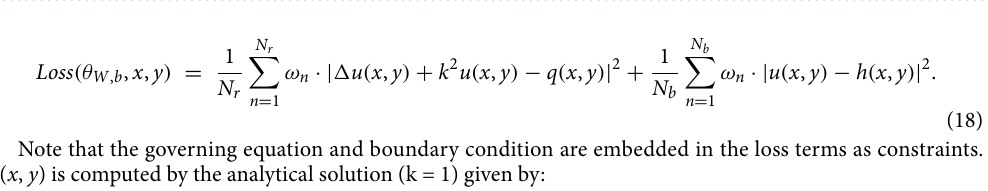
Figure 3. The convergence of DFS-Net (on the log scale) on the Helmholtz equation. The Adam optimizer is used before the vertical dashed line, and the L-BFGS-B optimizer is used